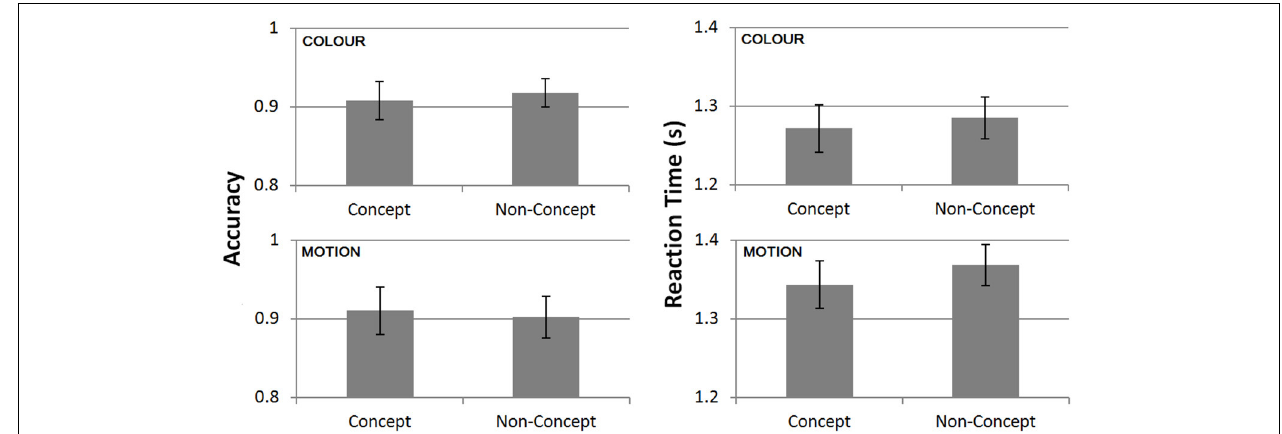
FIGURE 3 | Task performance from the scanning session averaged across all subjects ( n = 16). Mean accuracies (left) and reaction times (right) split between concept and non-concept conditions. Reaction times (RTs) are plotted relative to the onset of the second